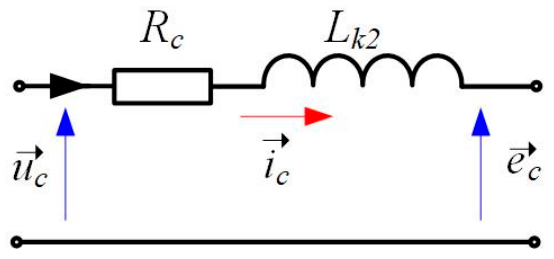
Figure 4. Control Winding (CW) equivalent circuit diagram.